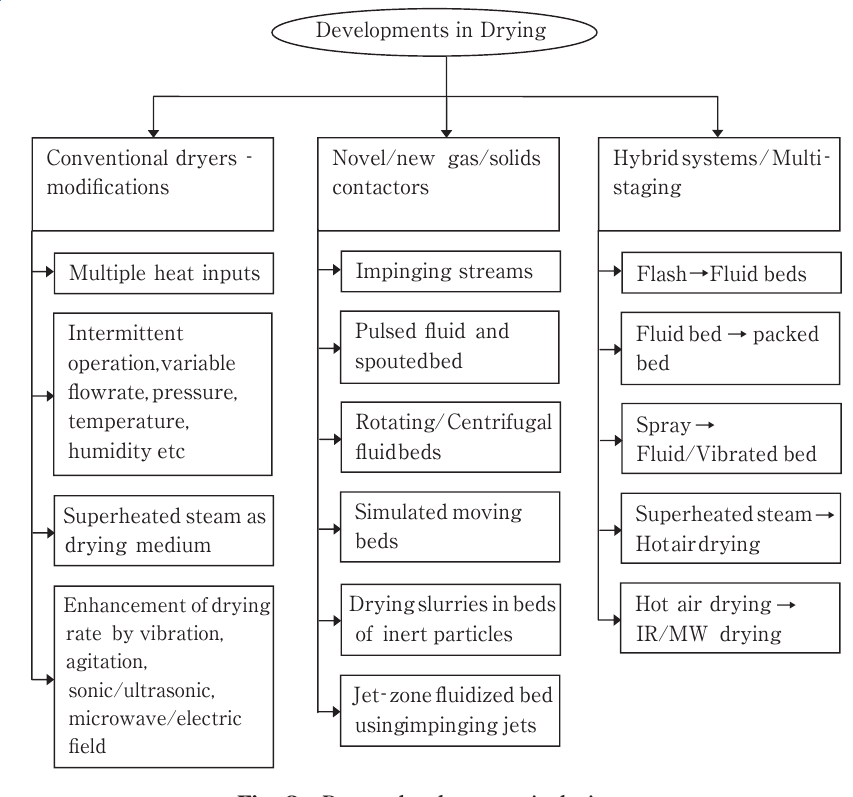
Fig. 3 Recent developments in drying.